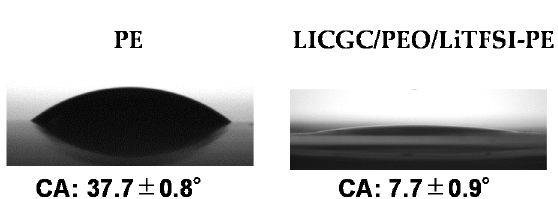
Figure 2. Contact angle measurements of the PE and the LICGC/PEO/LiTFSI-PE separators against the electrolyte.